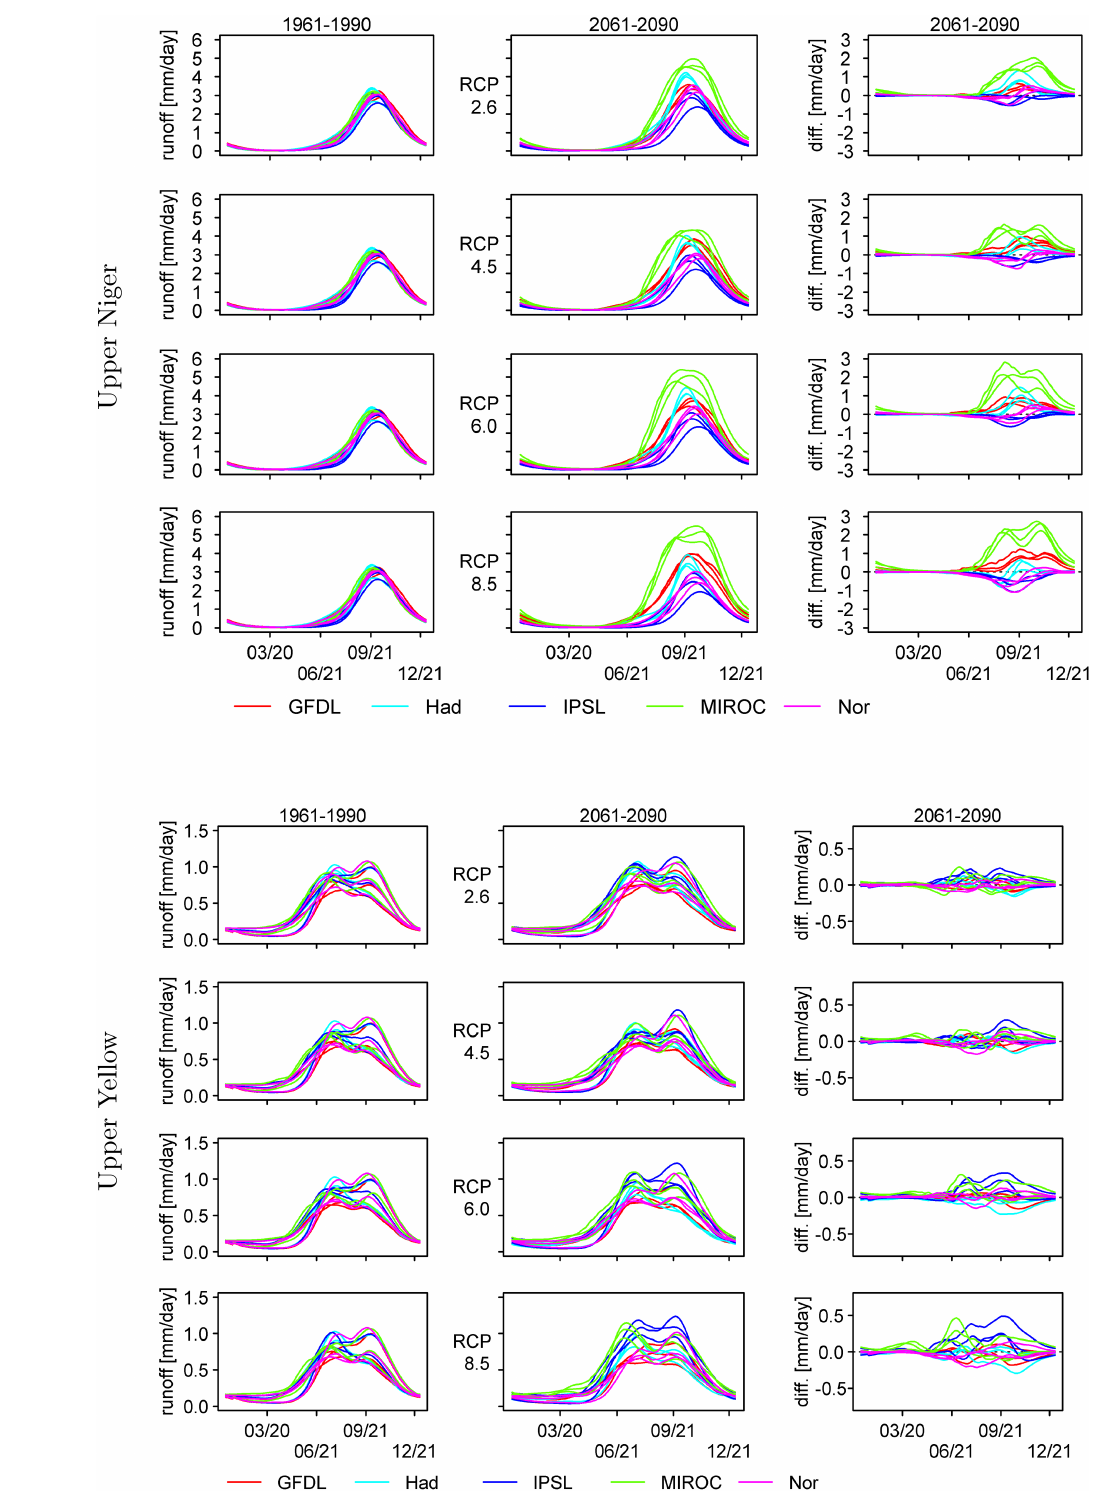
Earth Syst. Dynam., 6, 17–43, 2015